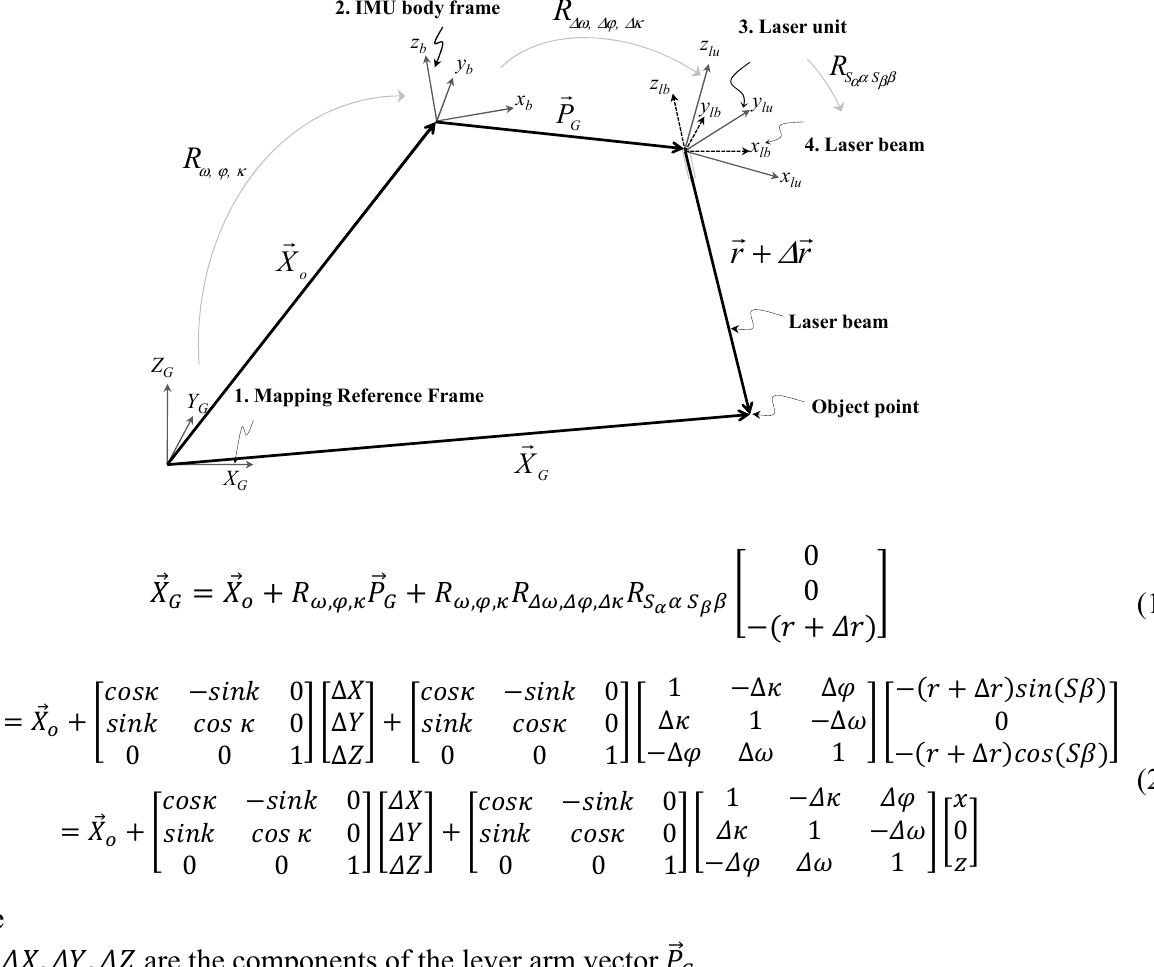
Figure 1. Coordinate systems and involved quantities in the LiDAR point positioning